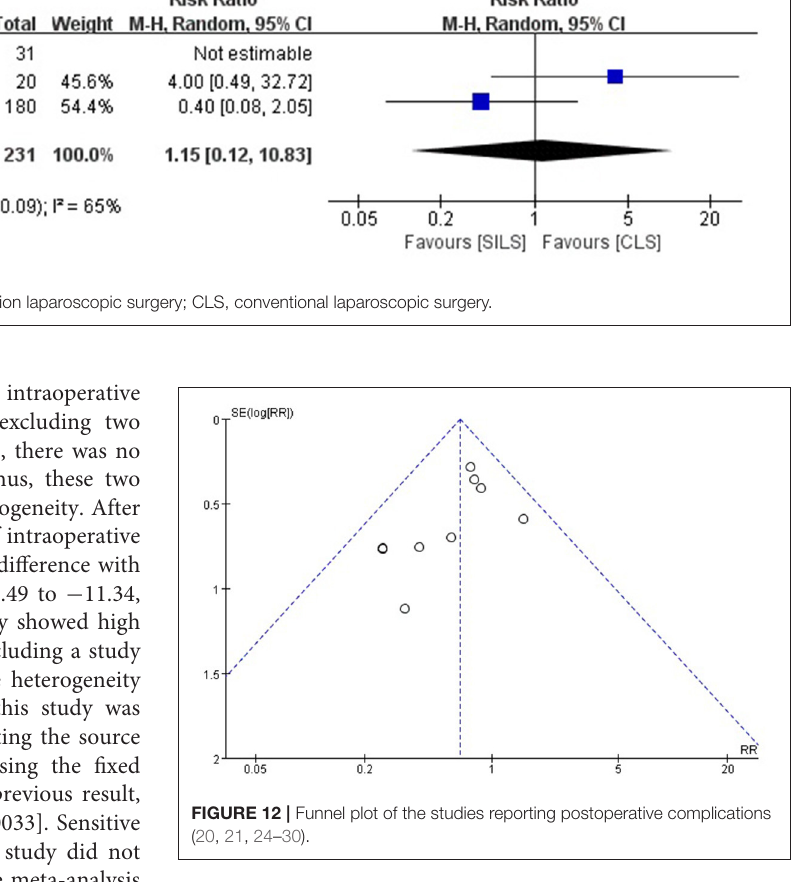
FIGURE 12 | Funnel plot of the studies reporting postoperative complications ( 20, 21,